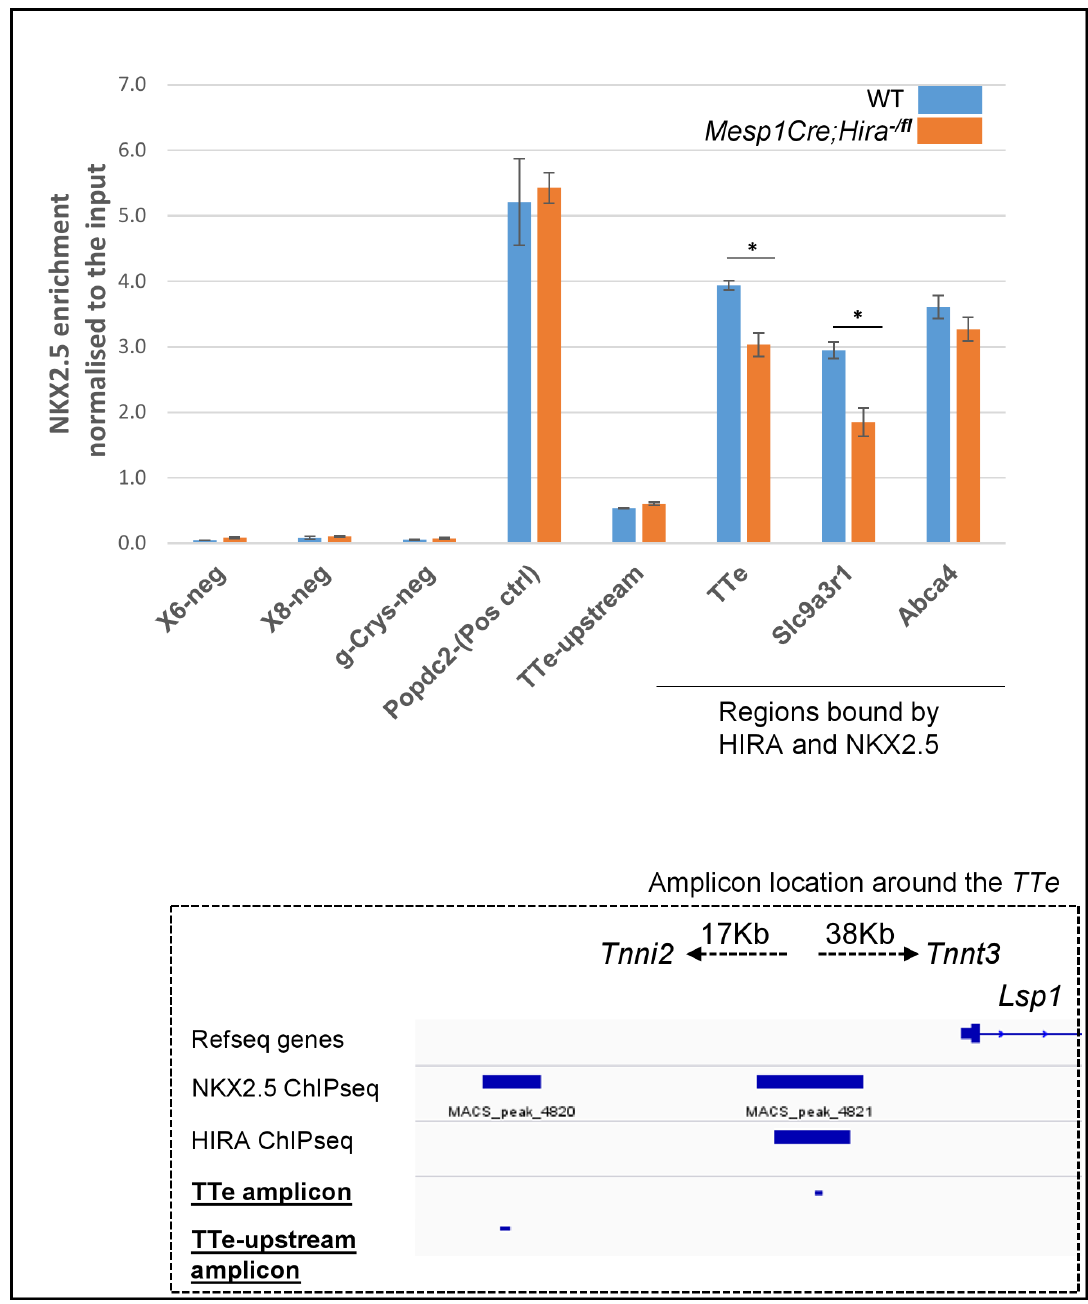
Fig 6. NKX2.5 shows diminished binding at the TTe locus in conditionally HIRA depleted hearts. NKX2.5 qChIP on 20 WT and Mesp1Cre ; Hira -/fl E12.5 hearts. Enrichment at the TTe was confirmed and found to be reduced in mutant hearts. Slc9a3r1 and Abca4 were enriched for both HIRA and NKX2.5 in WT hearts and displayed an increased expression in both Hira and Nkx2 . 5 mutant hearts. SLc9a3r1 , but not Abca4 , showed a significantly reduced binding of NKX2.5 in the absence of HIRA. Three different negative regions were tested. A region known to be enriched for NKX2.5, but not HIRA, binding ( Popdc2) was used as a NKX2.5 qChIp positive control. Data is normalized to the input (= 100). Errors bars represent the min/ max from technical duplicates. Unpaired t-test: p < 0.05 * . Subpanel represents the different ChIPseq peaks along with the PCR amplicons used in the different qChIp at TTe , and at a locus bound by NKX2.5, but not by